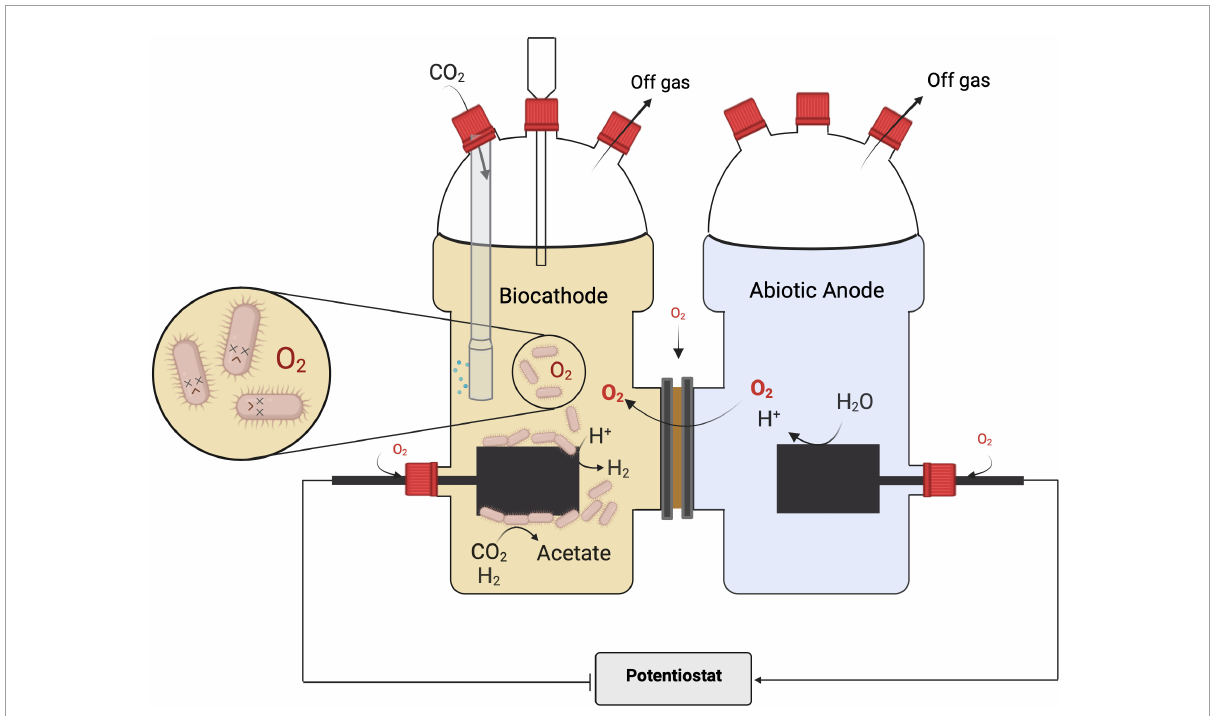
FIGURE1 Microbial electrosynthesis in an H-type reactor as the archetype of a two-chambered bioelectrochemical system and often used for microbial electrosynthesis (MES) from CO 2 (refer also to Table 1 ): the two chambers are separated by an ion-exchange membrane. As indicated, this setup provides more entry points for oxygen affecting the performance of the obligate anaerobic biocatalyst at the cathode with the main entry point being the membrane interface. Image created with